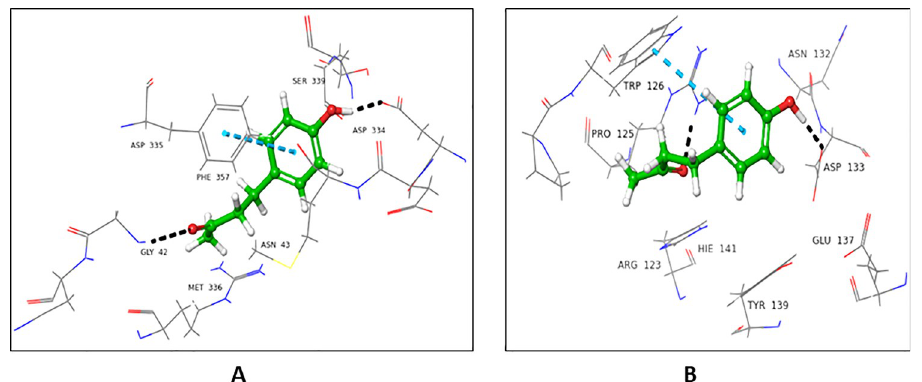
Fig 12. Interactions of compound 28 with the (A) donor and (B) acceptor domain of FUT2. 3D Ligand interactions diagram; blue dashed lines indicate π - π stacking bond while black dashed lines show hydrogen bond.